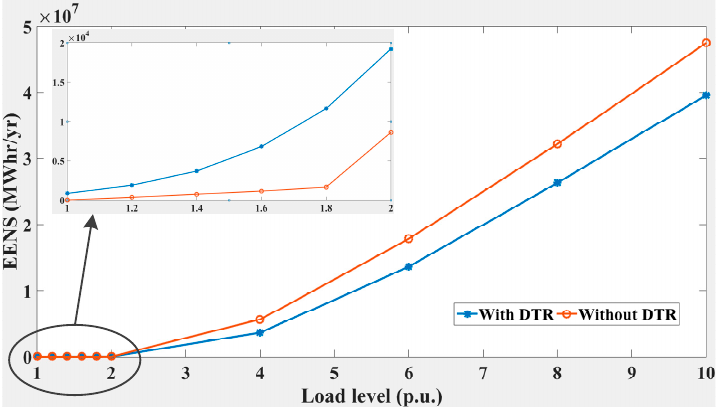
Figure 11. The EENS of BusSectorLS80 with and without the DTR system.